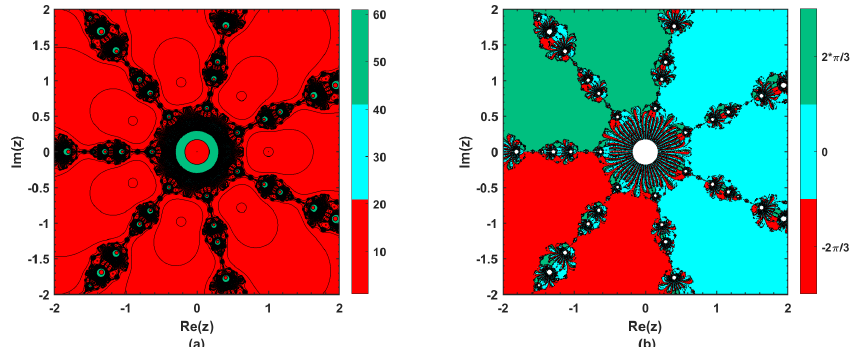
Figure 2. The polynomiographs obtained by the proposed method PS9 for P 2 ( z ) .